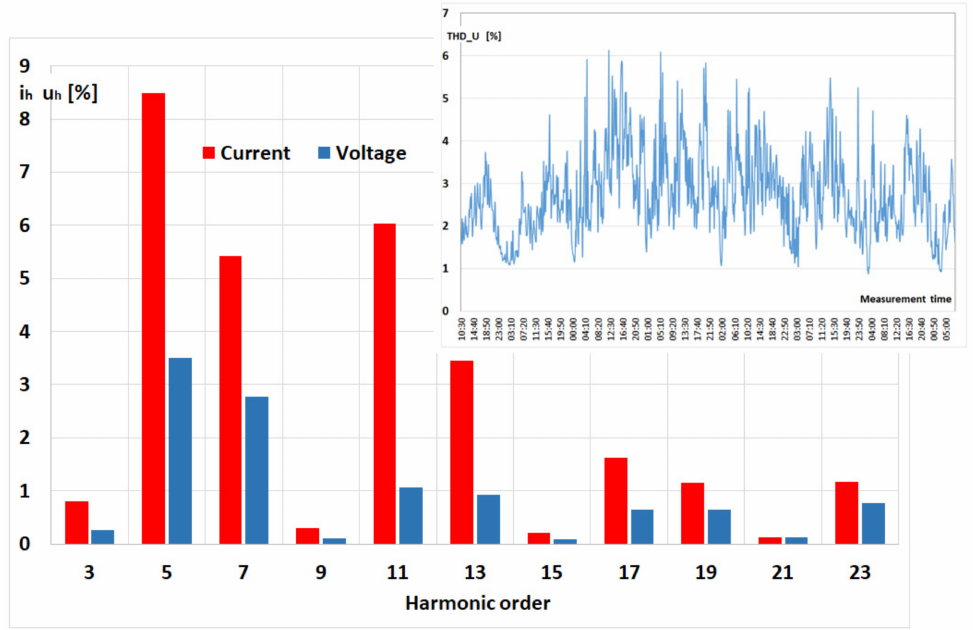
Figure 15. Spectrum of current, voltage harmonics and THDU recorded at point